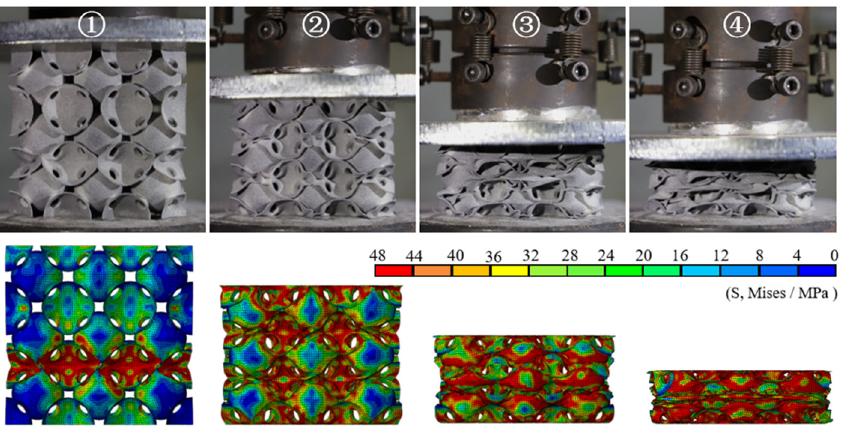
Figure 6. Deformed BCC structures at different stages.